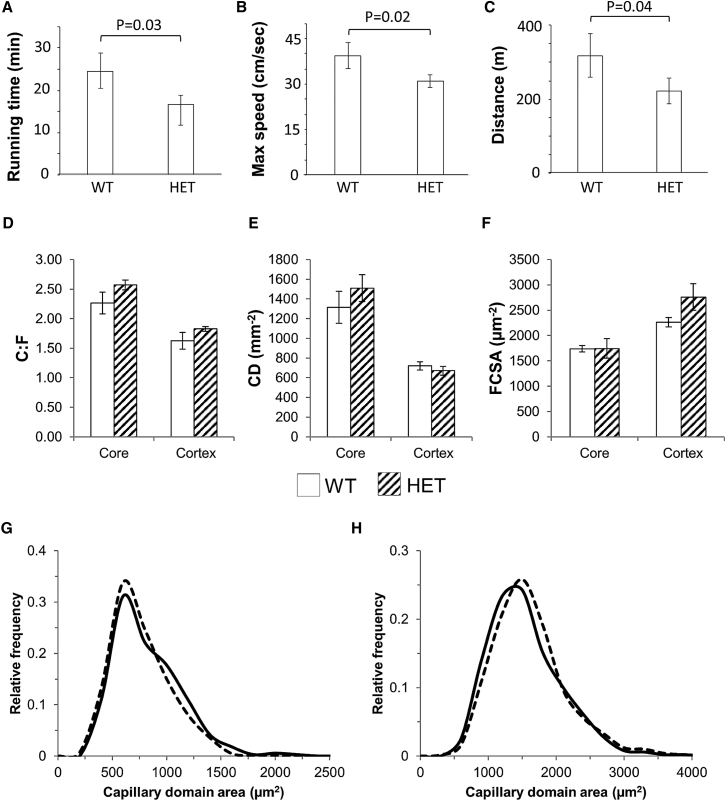
Exercise Capacity of Eif6 Heterozygote Mice(A) Running time in minutes to exhaustion of WT and Eif6+/− mice.(B) Maximum speed obtained (cm/s) by WT and Eif6+/− mice.(C) Total distance traveled by WT and Eif6+/− mice.(D–F) Capillary-to-fiber ratio (D), capillary density (E), and fiber-cross sectional area (FCSA) (F) in the oxidative core and glycolytic cortex of WT and Eif6+/− skeletal muscle. Data are represented as mean ± SEM.(G and H) The spatial distribution of capillaries as an index of diffusive limitation for gaseous exchange is shown by the distribution of capillary supply area (domains) in the oxidative core (G) and cortex (H) for WT and Eif6+/− skeletal muscle.